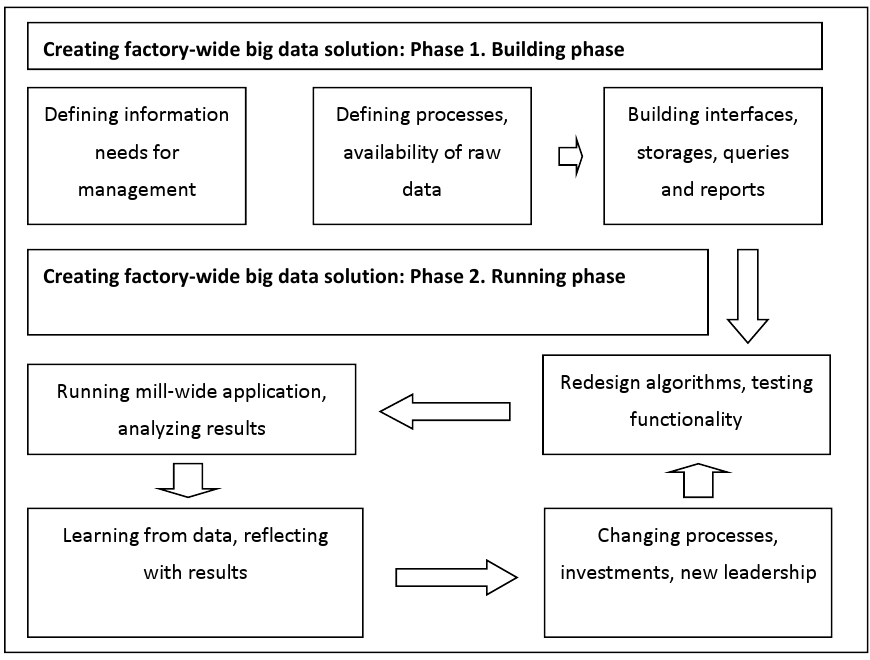
Figure 6. Two separate phases in the building of a solution for factory/mill-wide cost and environmental reporting.